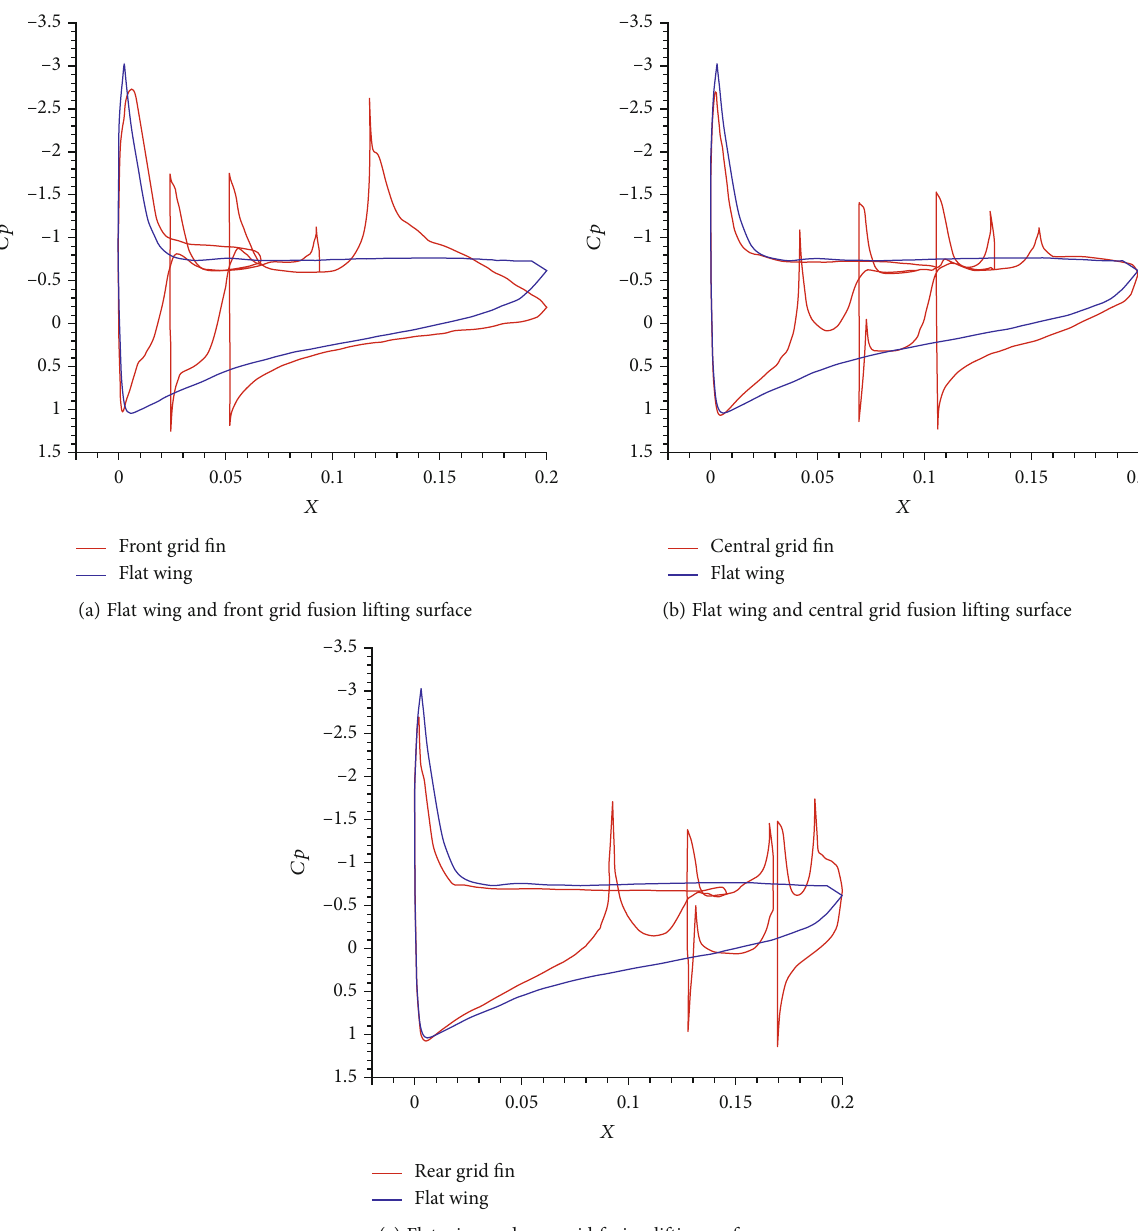
Figure 17: Pressure coe ffi cient diagram of fl at wing and grid fusion lifting surface with di ff erent grid Position ( Ma = 0 : 6 α = 28 ° z / b = 0 : 75